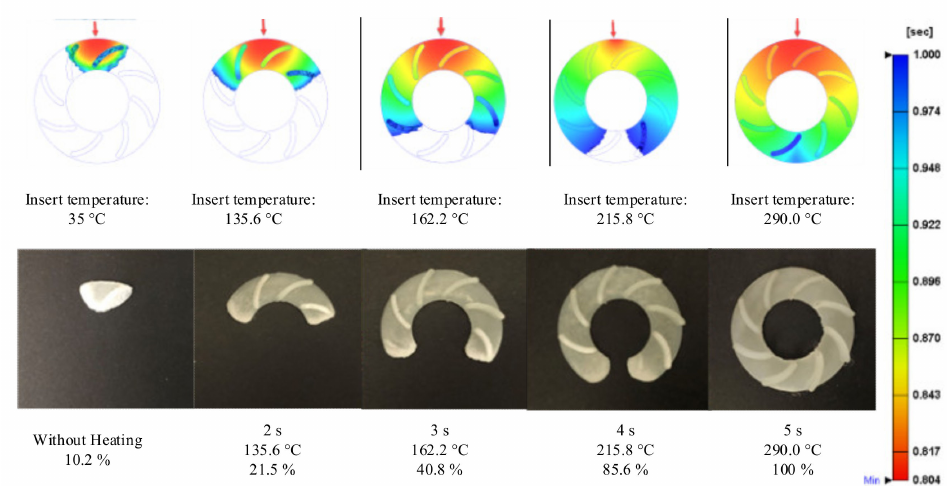
Figure 15. The simulation and experiment of thin-wall parts after molding with Ex-IH under different heating